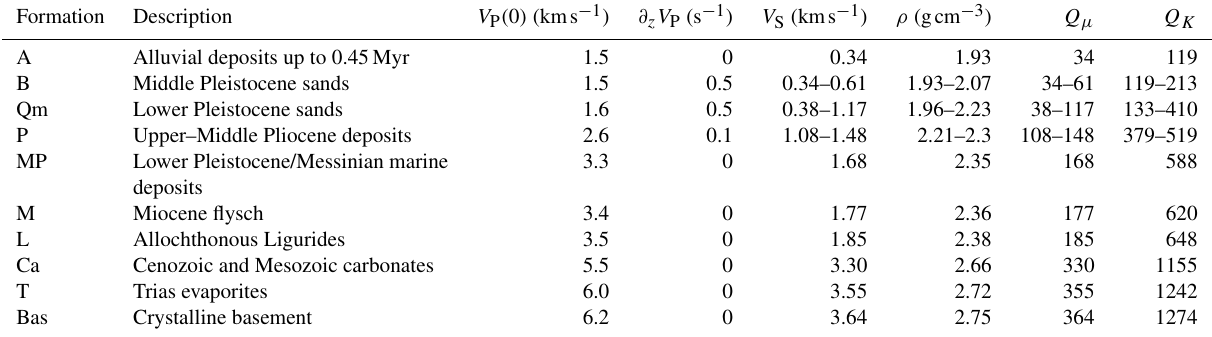
Figure 6. The fault system included in the 3-D model (east view) superimposed on the three cross-sections: B–B’, C–C’ and H–H’. Strati- graphic pile as in Fig. 4c. Table 1. Physical quantities assigned to each geological formation. V S , ρ , Q µ and Q K are evaluated from V P according to Eqs. (1)–(4).